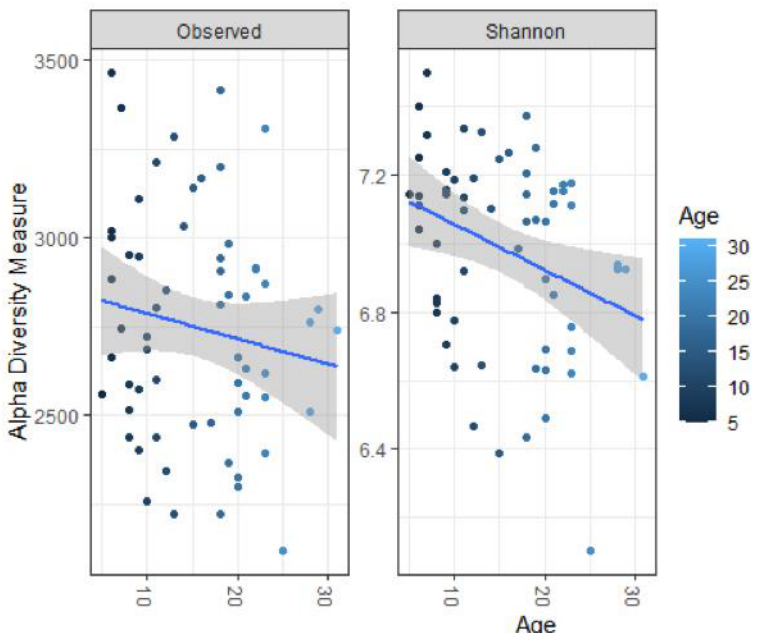
Figure 2. The effect of age on the observed richness and alpha-diversity (Shannon diversity index) on the faecal microbiota of 61 horses and ponies. A significant decrease, determined with linear modelling, in observed richness and alpha-diversity is visible in older horses.